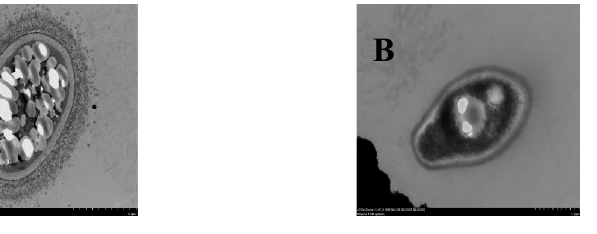
Figure 1. Transmission electron microscopy of two kinds of cells. ( A ) SCs, bars = 5 μ m; ( B ) YL, bars = 1 μ m. Table 1. Determination of the antioxidant capacity of the SCs and YL. Values are the means ± standard error of three independent replicates.